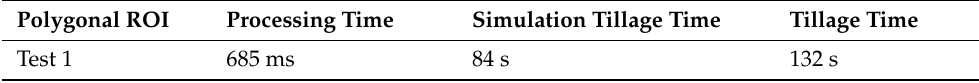
Table 4. Comparison of plowing process time between simulation results and field